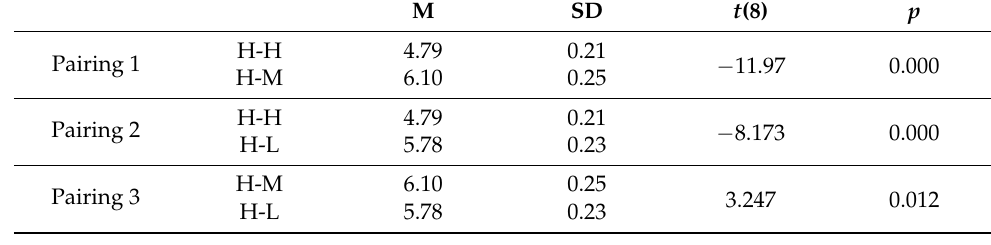
Table 2. Time distribution results table of high pitch–height.